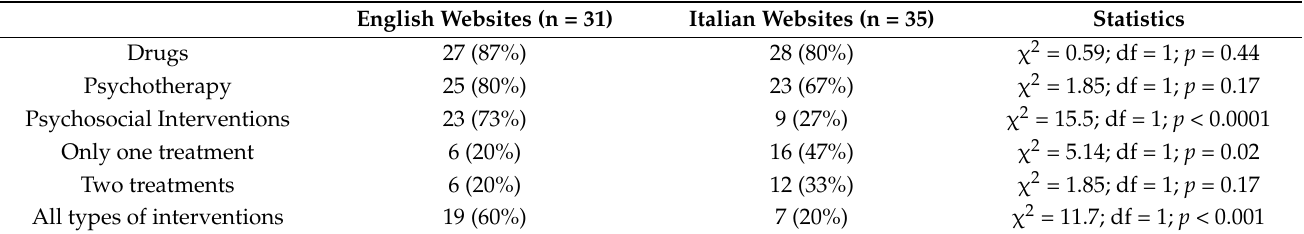
Table 2. Distribution of the treatments for BD as reported in the Italian and English